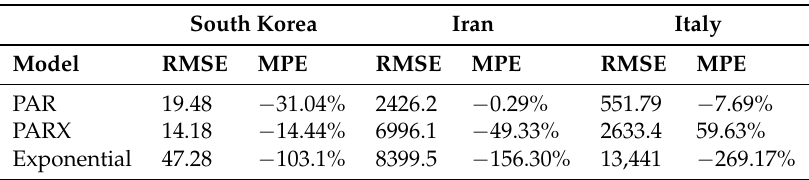
Table 2. Out-of-sample error